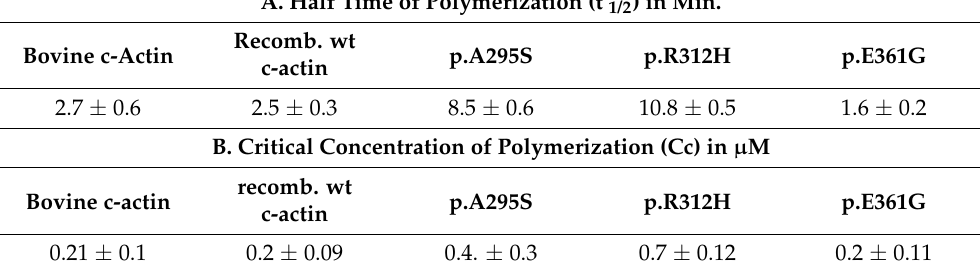
Table 1. A. Polymerization parameters (of 5 µ M c-actins) and B. critical concentrations of polymeriza- tion (Cc) of the cardiac actin